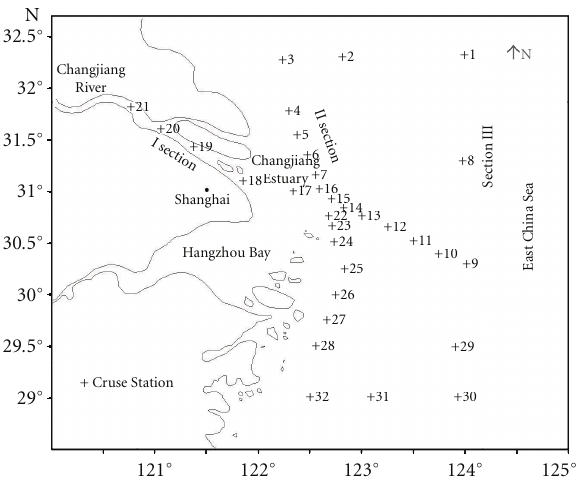
Figure 1: Location of sampling stations in June